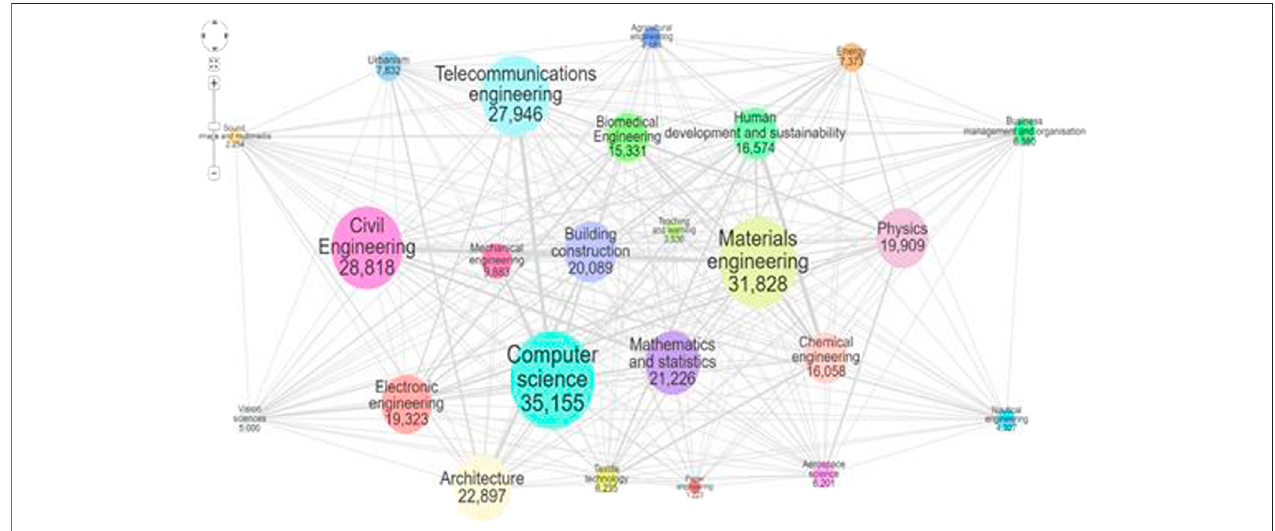
FIGURE 4 | Areas of knowledge and their relationship based on the scienti fi c production of UPC researchers. Source: Future UPC